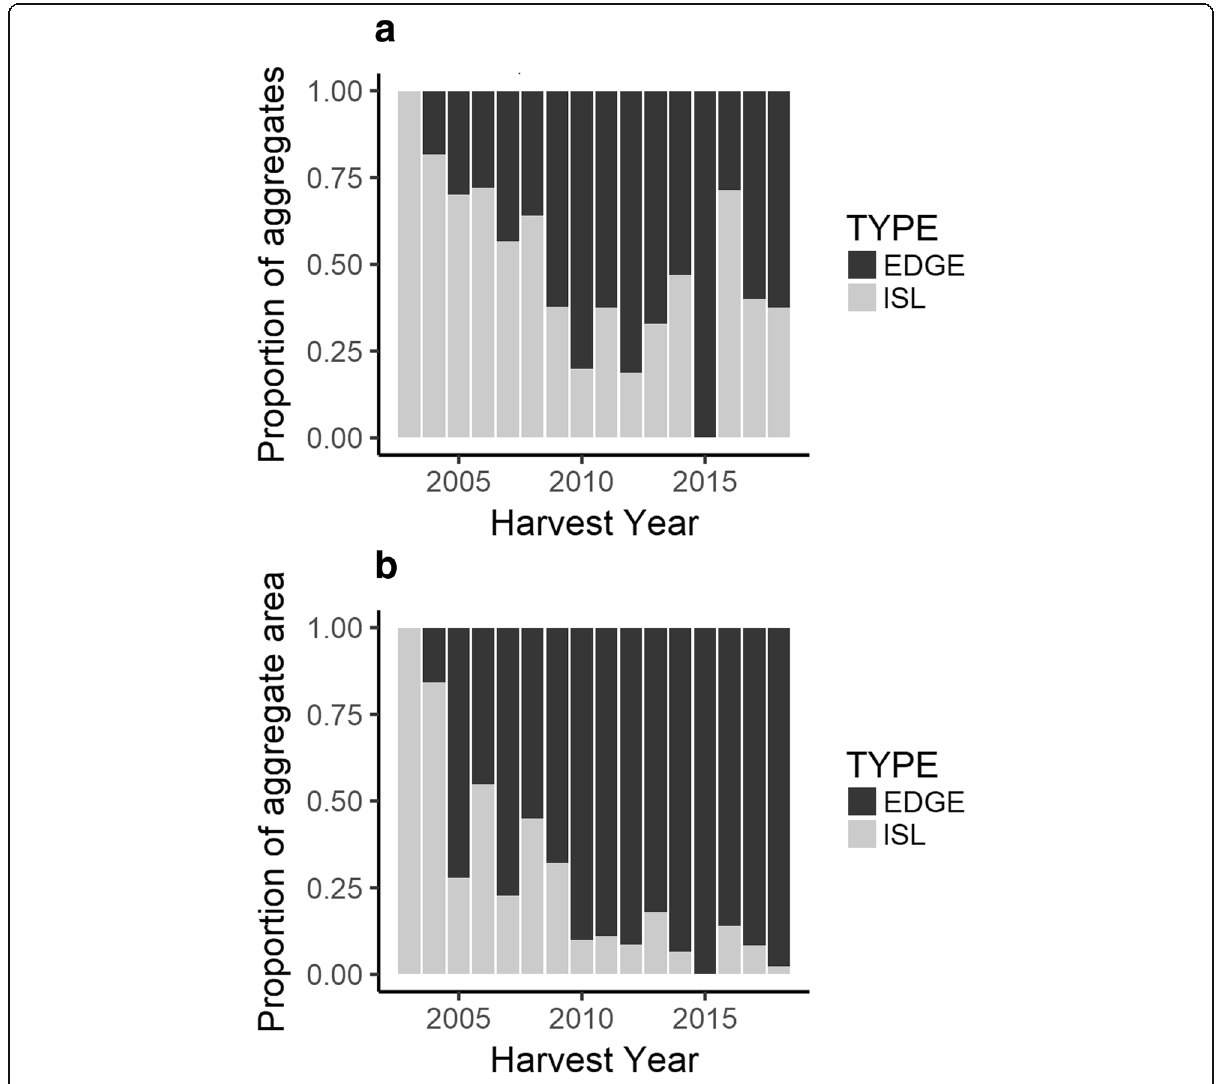
Fig. 6 Proportion of a total number of aggregates and b total aggregate area by aggregate type over time in ARN